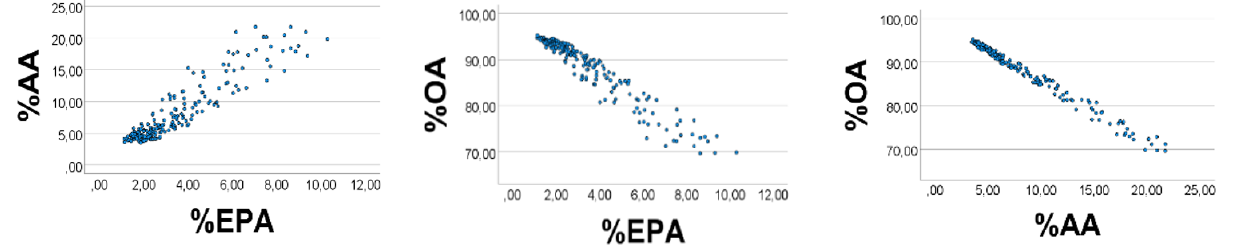
Figure 1. Associations between relative amounts of EPA ’ , AA ’ , and OA ’ , in a computer experiment with RANDOM numbers, see text. S = OA ’ + EPA ’ + AA ’ . RANDOM numbers ( n = 200) were used in lieu of true values; however, ranges were like those found in chicken muscle, i.e., 0.1–0.2 for EPA ’ , 0.3–0.4 for AA ’ , and 1–9 for OA ’ . %EPA ’ vs. %AA ’ : rho =0.890; %OA ’ vs. %EPA ’ (%AA ’ ): rho = −0.951 (−0.984), p < 0.001 for all. Note: In the figure we have omitted the random number mark ( ‘ ) on the variables.